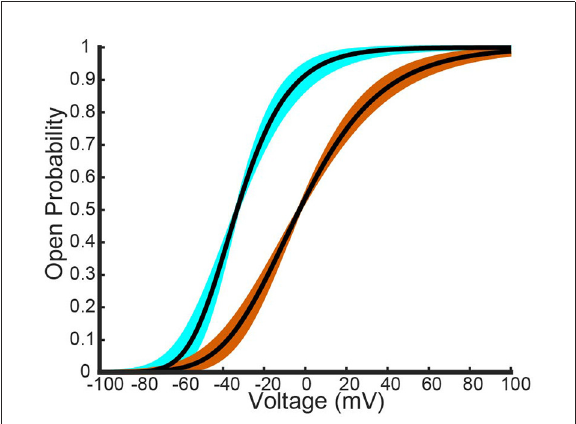
FIGURE3 Model outputs showing the voltage at which a particular probability of opening is achieved. The x-axis denotes the proportion of subunits/gates that are K V 1.1 vs. K V 1.2 with a = 4 corresponding to a K V 1.1 homomer with four subunits/gates. Each curve color corresponds to a different probability of opening from the model output. The data points are the Al-Sabi data points of each channel type for any given probability of opening and are colored accordingly. Although the non-integer values of a are irrelevant under the model framework, the curves are left for clarity of the trends moving from a = 4 to a = 0.